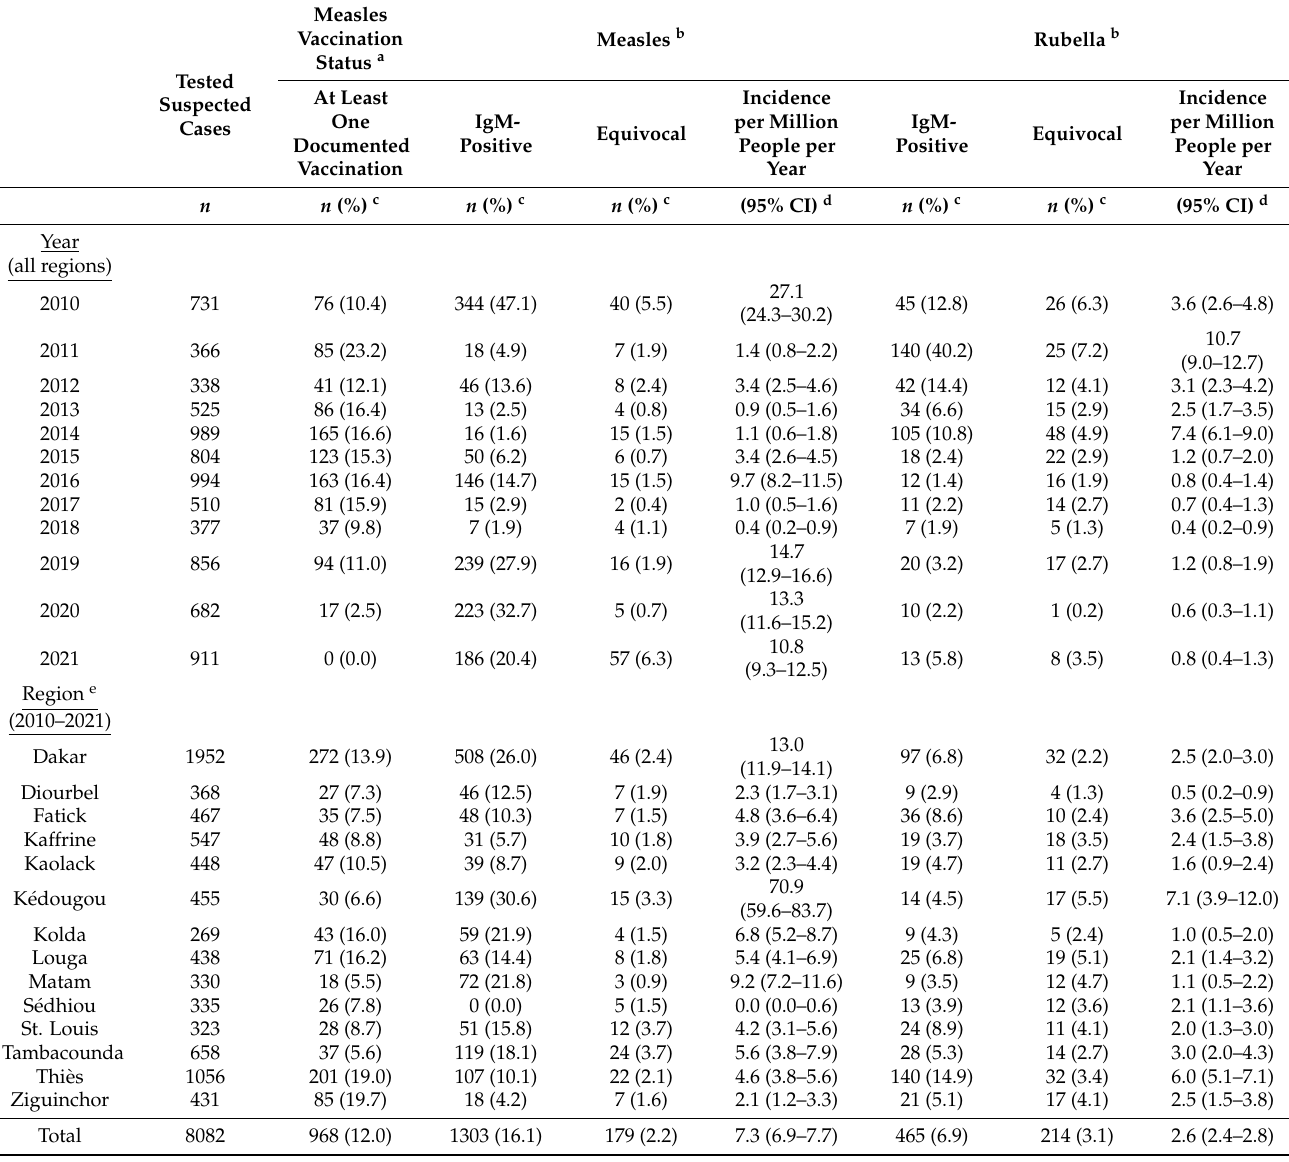
Table 2. The number and vaccination status of tested suspected cases, and the number and incidence of confirmed measles and rubella cases by year and